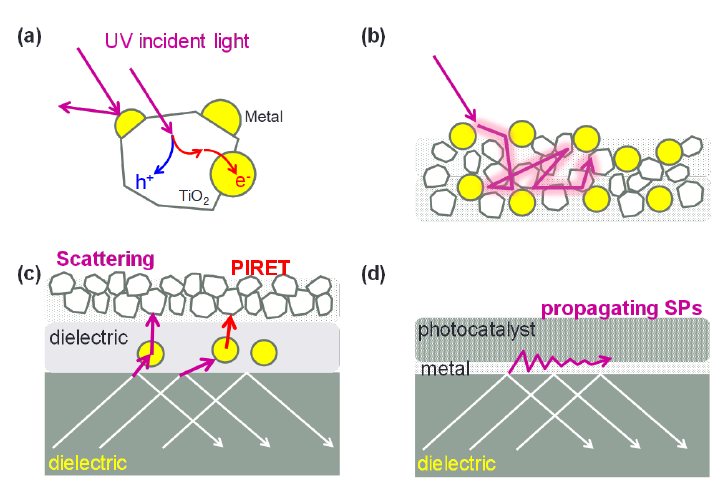
Figure 5. Near-field optical response of ( a ) binary heterogeneous photocatalyst, ( b ) binary polycrystal photocatalyst deposited on substrate, ( c ) embedded metal nanoparticles beneath the deposited polycrystal photocatalyst, and ( d ) metal thin film beneath the deposited photocatalyst layer. High-wavevector lights illuminating the substrate from below induce substantial coupling of light energy in ( c ) and ( d